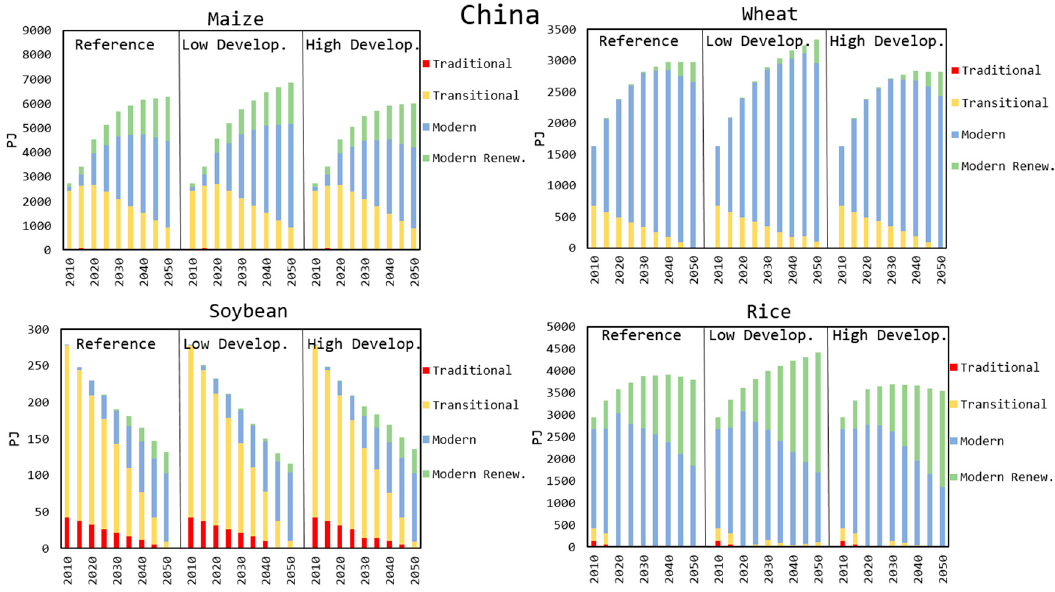
Figure 10. Technological diffusion for reference, low and high development scenarios in China.